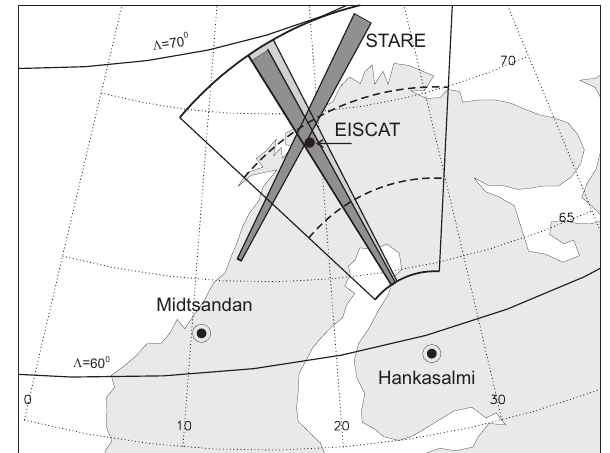
Fig. 1. Field-of-view of the Hankasalmi CUTLASS HF radar for ranges between 300 and 1200km at the height of 110km. Dashed lines are slant ranges of 600 and 900km. The lightly shaded sec- tor is the location of the CUTLASS beam 5. The darker beam-like sectors are the location of the Finland STARE radar beam 3 and the Norway STARE radar beam 4. The solid dot denotes the area where ionospheric parameters were monitored by the EISCAT inco- herent scatter radar. Also shown are PACE lines of equal magnetic latitudes 3 = 60 ◦ and 3 = 70 ◦